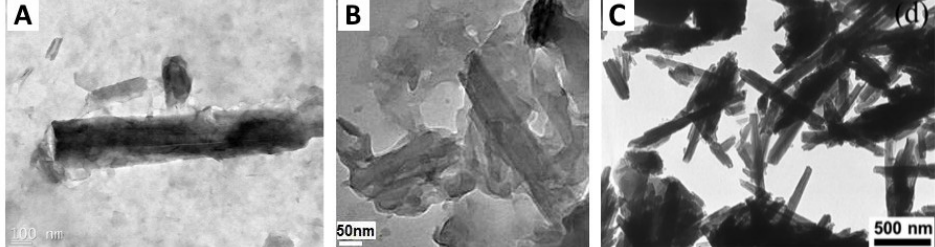
Figure 9. ( A ) HNTs wrapped by DNA. Reproduced with permission from Ref. [86]. Copyright 2008 IOP Publishing, Ltd., ( B ) HNTs modified by lysozyme. Reproduced with permission from Ref. [134]. Copyright 2015 Royal Society of Chemistry, ( C ) HNTs grafted by chitosan. Reproduced with permission from Ref. [99]. Copyright 2016 Royal Society of Chemistry.